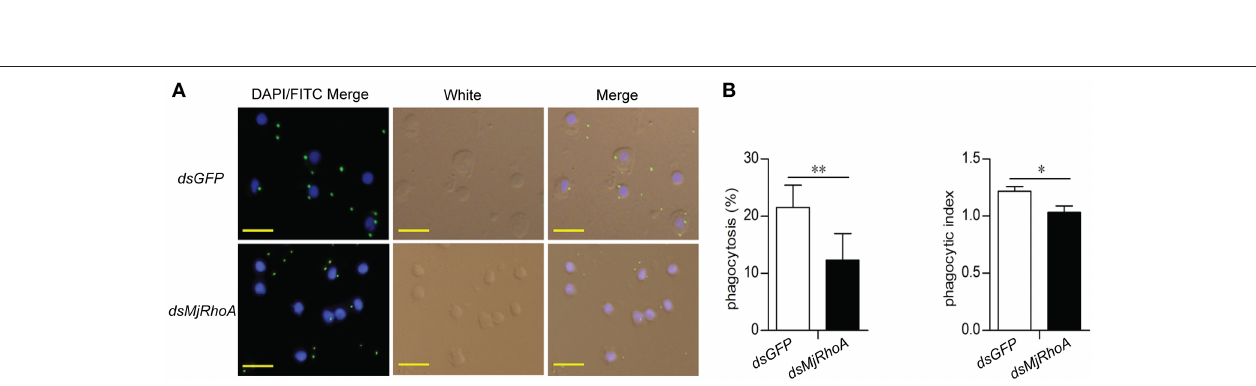
FIGURE 3 | Mj RhoA bacterial clearance was dependent on phagocytosis. (A) Bacterial phagocytosis of hemocytes was analyzed by immunocytochemistry. The phagocytosis detection with hemocytes from dsGFP -injected shrimp was used as a control. (B) The phagocytosis rate and the phagocytic index calculated after counting hemocytes injected with FITC- V. anguillarum . At least 100 cells were counted and three different views were chosen for statistical analysis. * p < 0.05, ** p < 0.01.